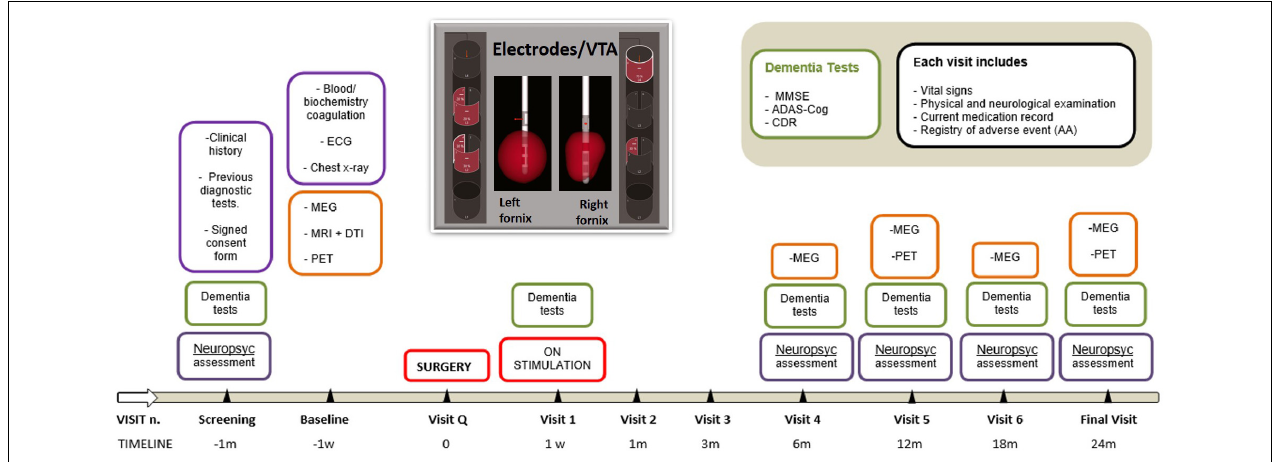
FIGURE 1 | The timeline of the study.